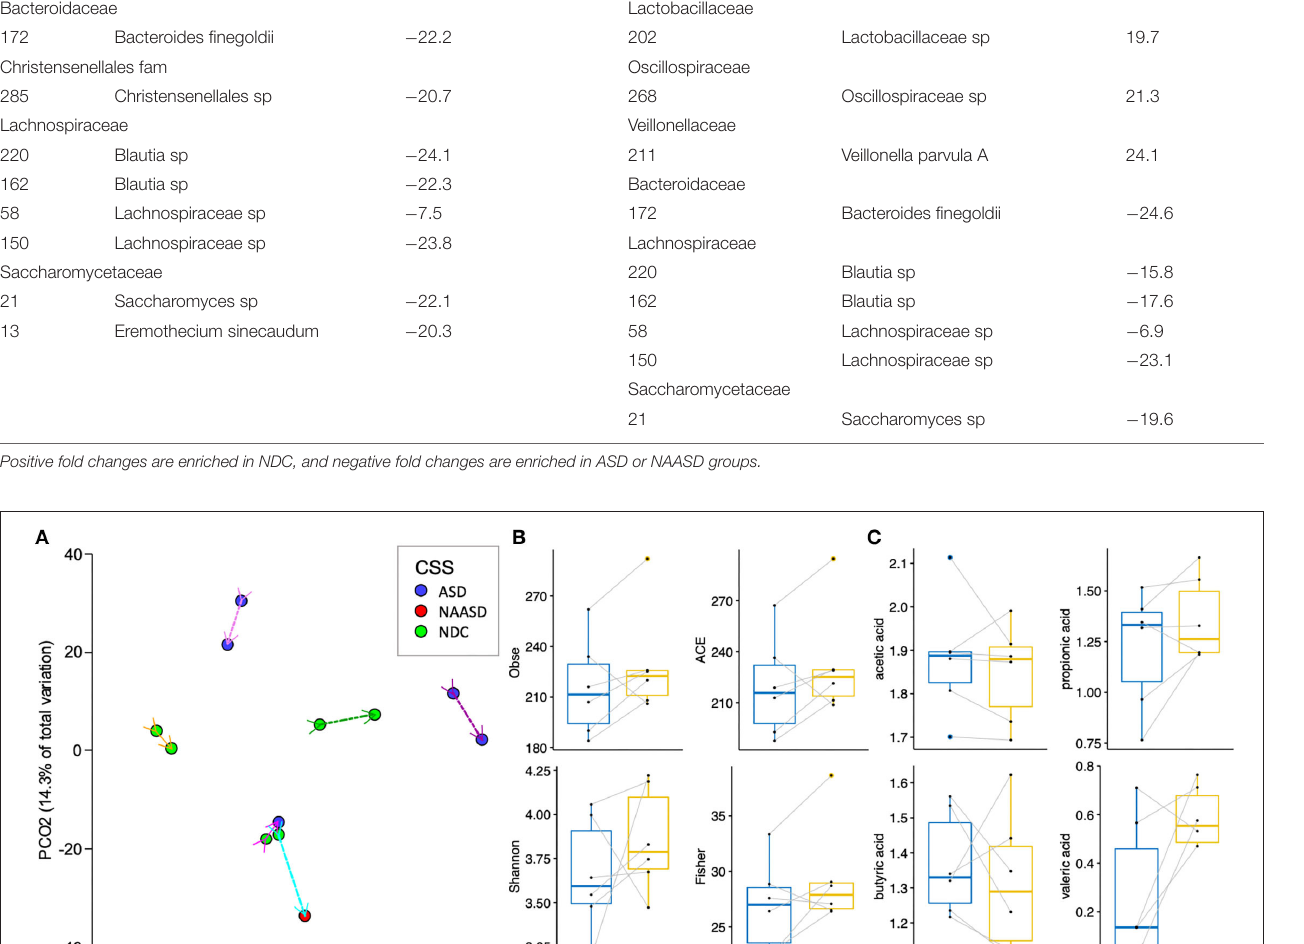
microbial community may differ due to the ASD